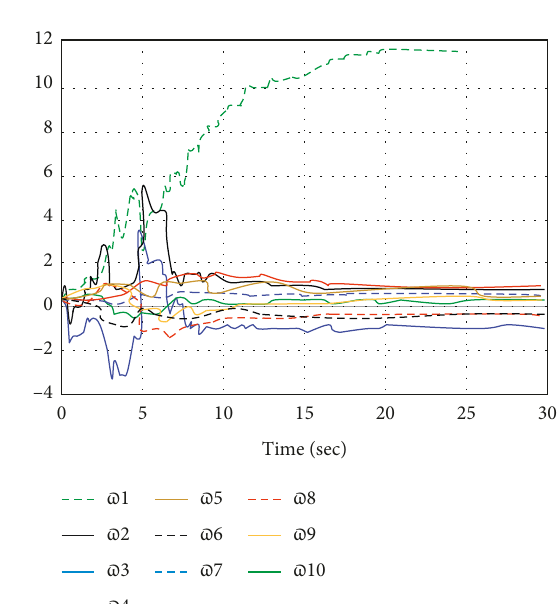
Figure 2: Overall planning scheme of the project.